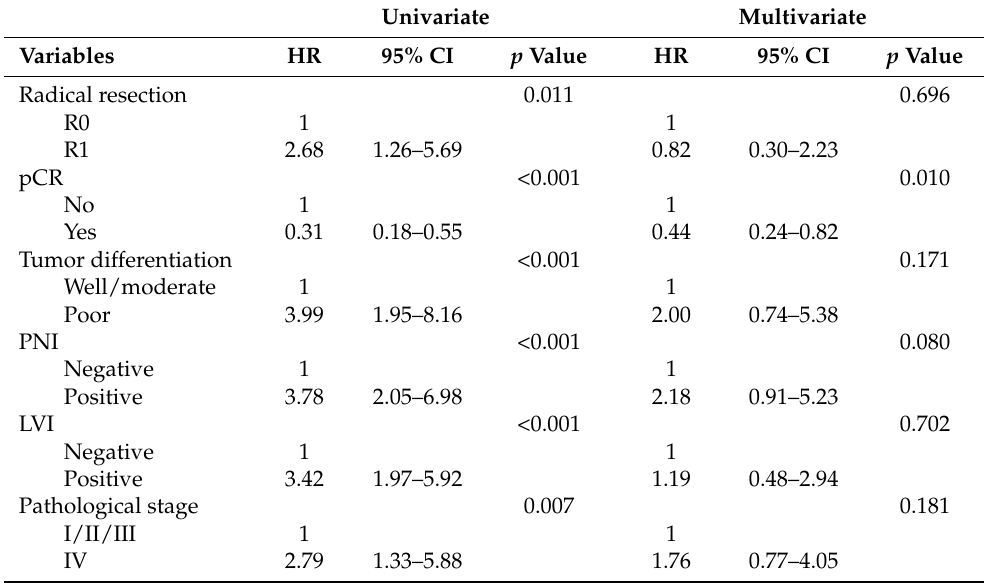
Table 2. Univariate and multivariate Cox regression model for overall survival.